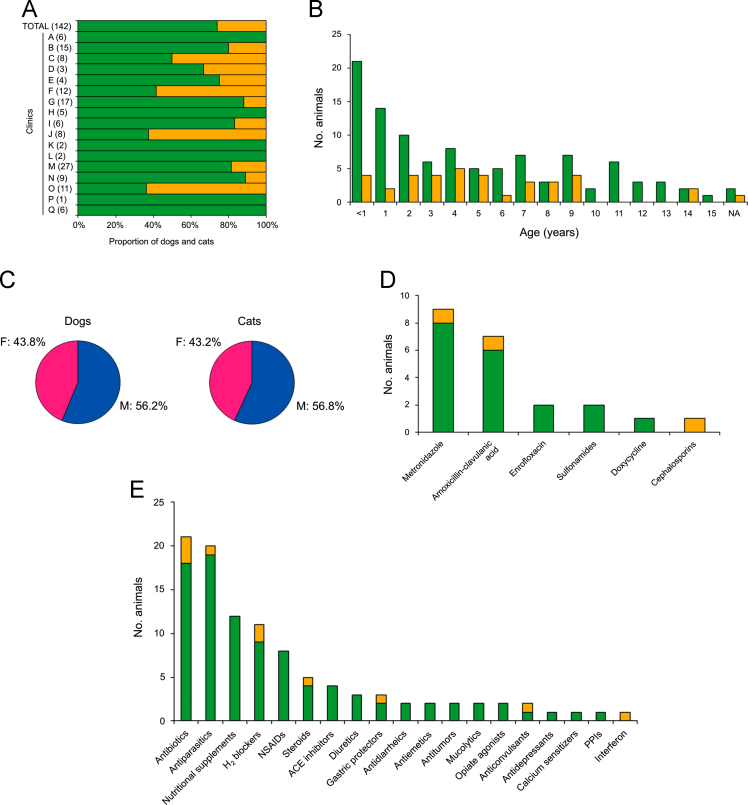
Characteristics of the animal populations recruited for this study. A) Bar plot showing the distribution of recruited animals per species: dog, green bars; cats, orange bars. For each participating clinic (A to Q), the overall number of animals is indicated between parentheses. B) Bar plot of the overall age distribution of dogs (n=105; green bars) and cats (n=37; orange bars) recruited for the study. C) Pie charts of the overall sex distribution of dogs (n=105) and cats (n=37) included in the study. Blue and pink sectors represent male (M) and female (F) subpopulations, respectively. D) Bar plot of the antimicrobial treatments administered to recruited dogs and cats (green and orange bars, respectively) ≤30 days before sampling. E) Bar plot of recent pharmacological treatments administered to recruited dogs and cats (green and orange bars, respectively) ≤30 days before sampling. Abbreviations: ACE, angiotensin-converting-enzyme; NSAIDs, nonsteroidal anti-inflammatory drugs; PPIs, proton pump inhibitors. In panels D and E, pharmacological treatment data were not available for a total of 48 animals (32 dogs and 16 cats).